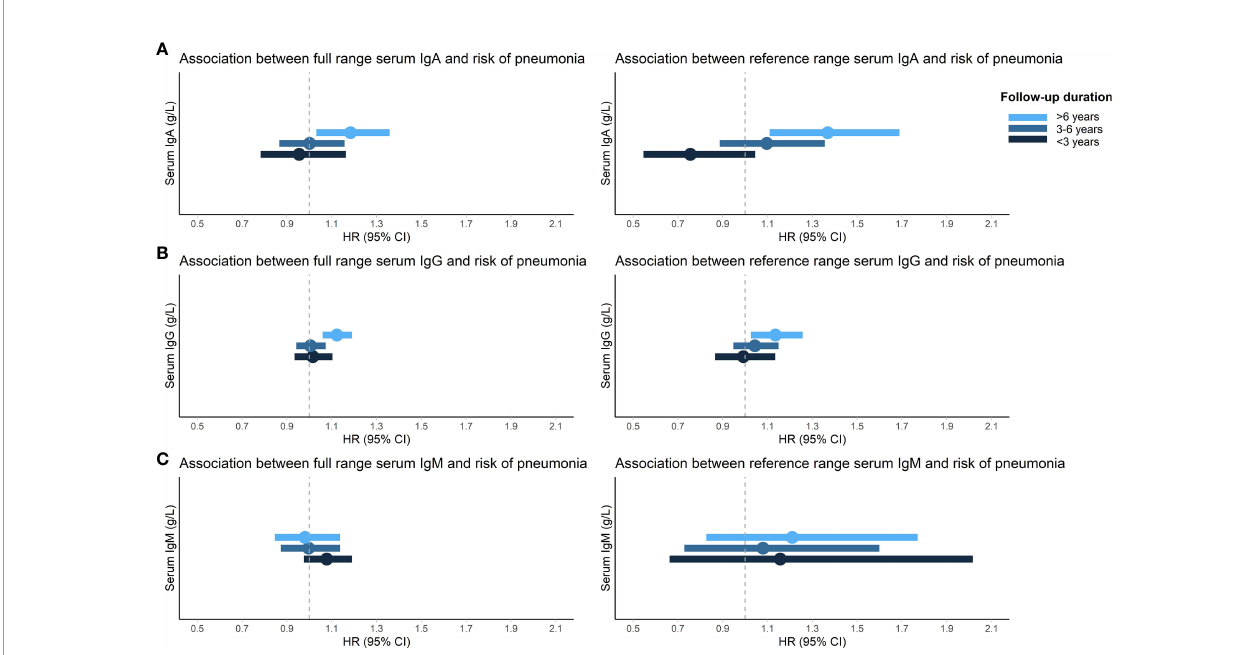
FIGURE 1 | Association between serum immunoglobulins and risk of incident pneumonia. Displayed are the associations of IgA (A) , IgG (B) , and IgM (C) with risk of incident pneumonia strati fi ed by follow-up duration. HRs (dots) and 95% CIs (horizontal bars) are displayed for both the full and reference range of serum immunoglobulins. Reference range was de fi ned as 2.5 th -97.5 th percentiles of this population (0.86-4.76 g/L for IgA, 6.20-15.10 g/L for IgG, and 0.28-2.64 g/L for IgM) and exclusion of medication use that can in fl uence serum immunoglobulin levels and/or pneumonia risk (pneumococcal vaccines, inhaled or oral corticosteroids, proton pump inhibitors, angiotensin converting enzyme inhibitors, antiepileptic or antipsychotic drugs). HRs are adjusted for age, sex, Rotterdam Study cohort, smoking status, pack years, and alcohol consumption. IgA/ IgG/IgM, immunoglobulin A/G/M; HR, hazard ratio; 95% CI, 95% con fi dence